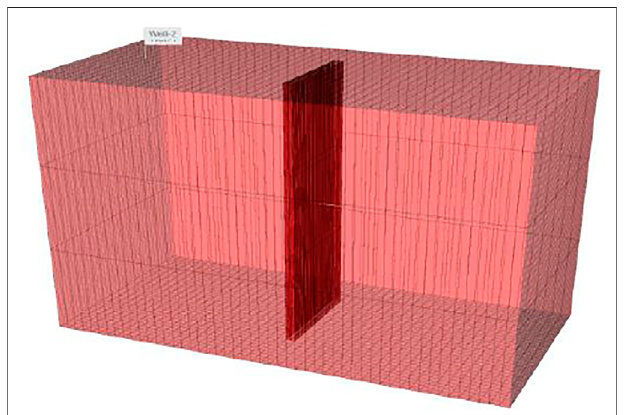
FIGURE 6 | Changing curves of the cumulative gas production after 10- day shut-in and 3-year production for different initialwater saturation